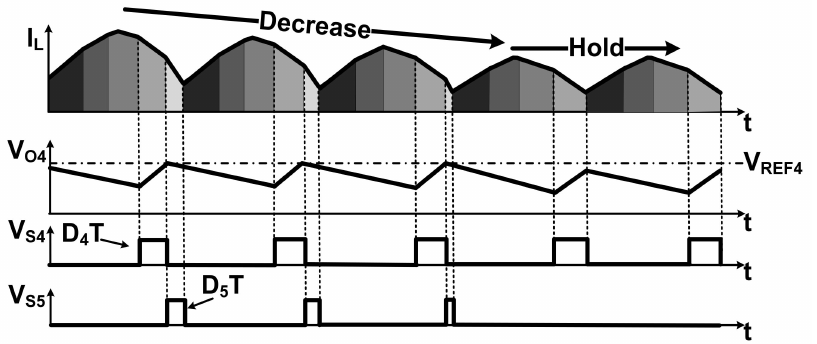
Figure 4. Timing diagram of the hybrid converter when the on-time duration of the freewheeling switch gradually